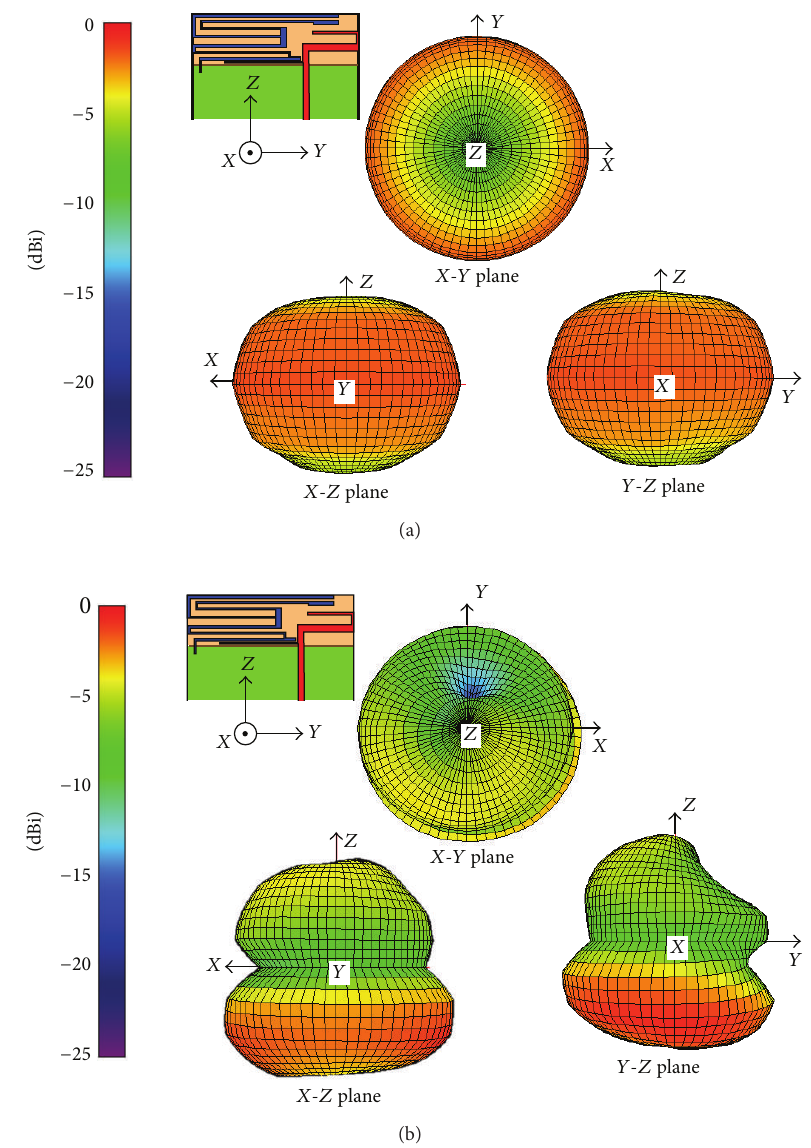
Figure 10: Measured three-dimensional radiation pattern at (a) 750 MHz and (b) 2500